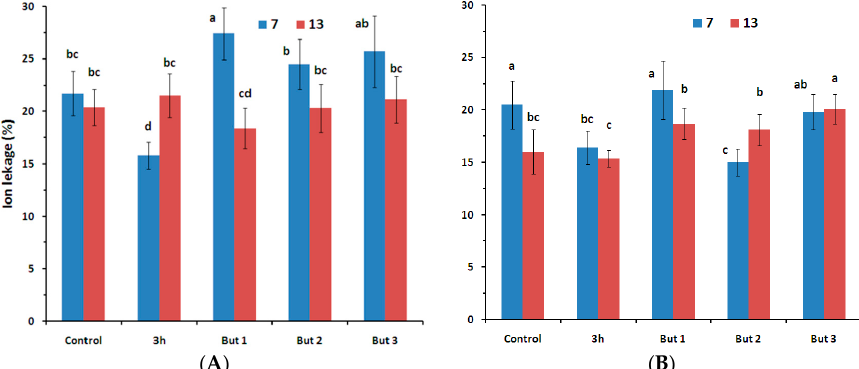
Figure 2. Percentage ion leakage from seeds of two L. angustifolius cultivars (Lazur—( A ); and Sethes Fruehe Rote—( B )) germinated at 7 °C (blue bars) or 13 °C (red bars) in water (control), butenolide or hydroprimed in water for 3 h at 20 °C. But 1, But 2, But 3: 10 − 6 M, 10 − 5 M, 10 − 4 M butenolide, respectively. Letters over error bars (±SE; n = 10) indicate significant differences (Duncan’s multiple range test, p < 0.05).